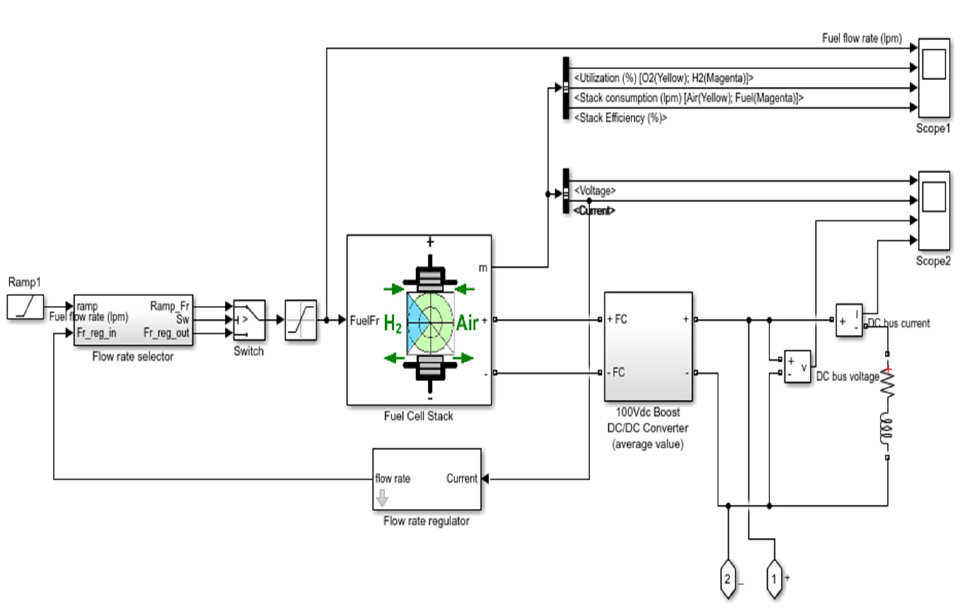
Figure 6. Simulink model of fuel stack. Multiple connections of solar cells constitute solar panels while the placement